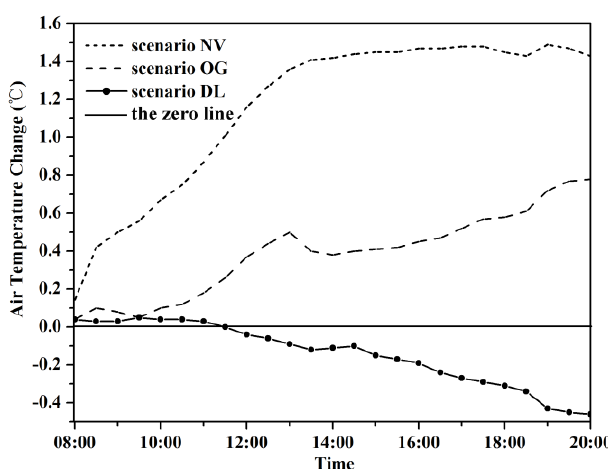
Figure 6. Air temperature difference of green modification scenarios compared with the base case at 1.5 m above ground. NV, OG and DL are short for No Vegetation, Only Grass and Double LAD respectively.